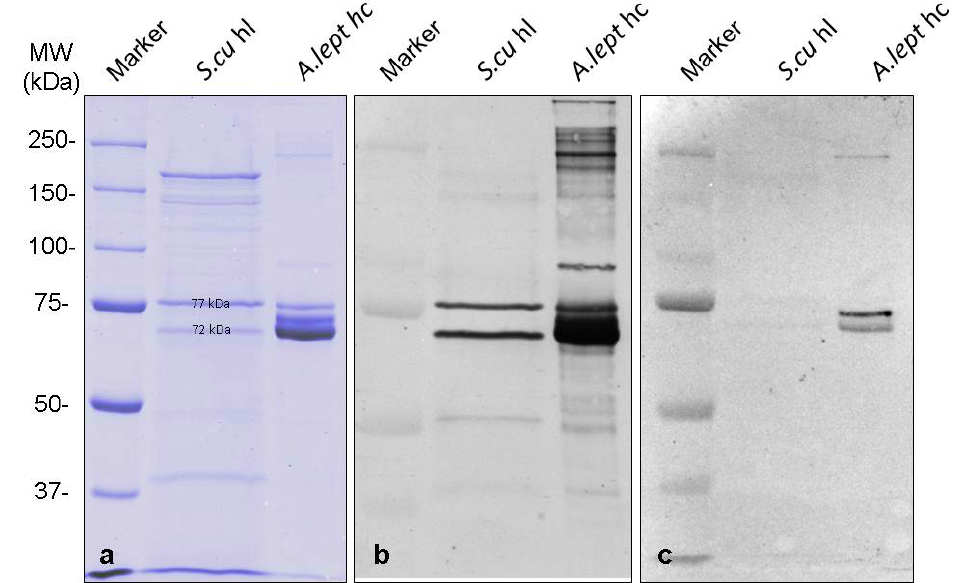
Figure 2. Identification of two hemocyanin subunit types in S. curviseta hemolymph by Western blotting. ( a ) SDS-PAGE (pH: 8.8, 7.5%). Marker: Biorad Precision Plus Unstained Standards. S.cu hl = Sinella curviseta hemolymph. A. lep hc = Astacus leptodactylus hemocyanin. ( b ) Western blot with antibodies against hemolymph proteins from crab Astacus leptodactylus . Two bands at about 72 and 77 kDa from Sinella curviseta hemolymph are strongly recognized, while various proteins from semi- purified A. leptodactylus hemocyanin are observed. ( c ) Western blot with antibodies against purified tarantula hemocyanin. Two strong bands of semi-purified A. leptodactylus hemocyanin can be observed but only two very weak bands from Sinella curviseta hemolymph bands can be detected. Marker: Biorad Precision Plus Dual Color Standards. Blot was scanned black and white.